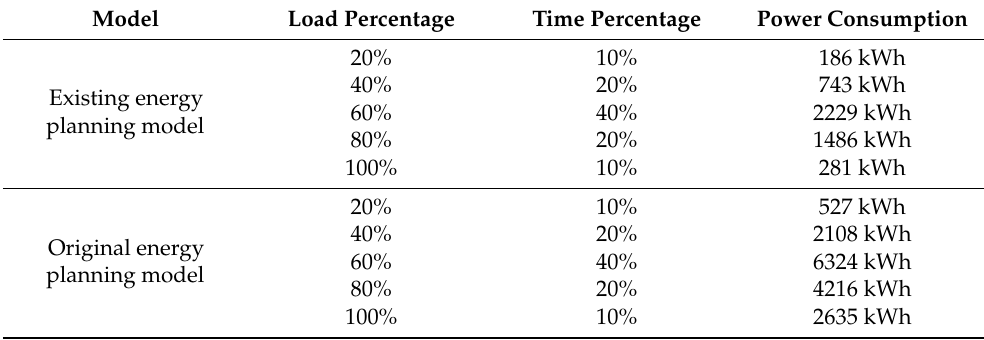
Table 2. Results of the original energy planning model and the existing energy planning model.